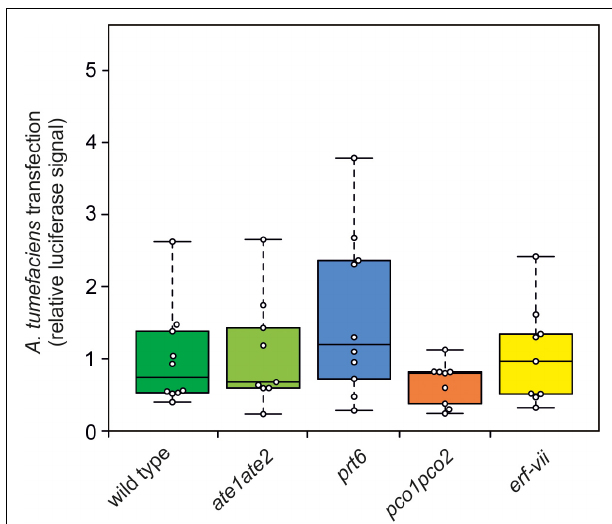
FIGURE 6 | N-end rule mutants do not show altered susceptibility to A. tumefaciens infection. Quantification of the relative luminescence of leaves from wild type, ate1ate2 , prt6 , pco1pco2, and erf-vii lines infiltrated with a disarmed GV3101 A. tumefaciens strain carrying a Renilla luciferase reporter. The Renilla luciferase gene carries an intron to restrict its expression in Agrobacterium . Relative luciferase signal of each genotype was calculated per µ g of protein. ANOVA was performed to test for statistically significant difference between the